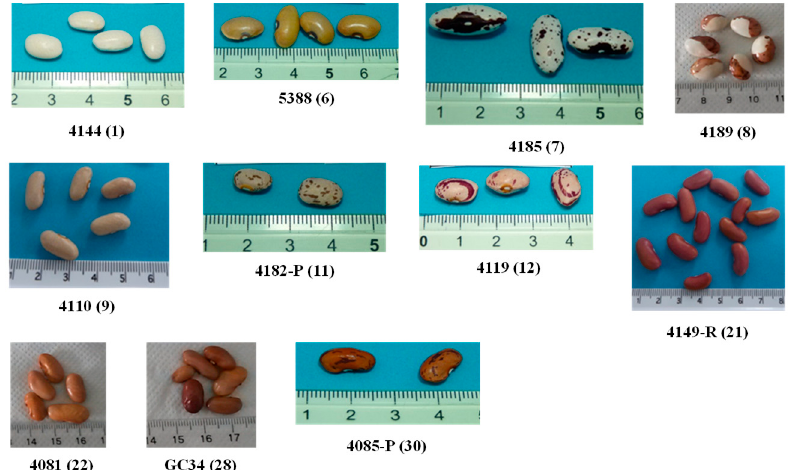
Figure 1. Example of ( Phaseolus vulgaris L.) common beans varieties morphological aspect (one variety from each color market class).